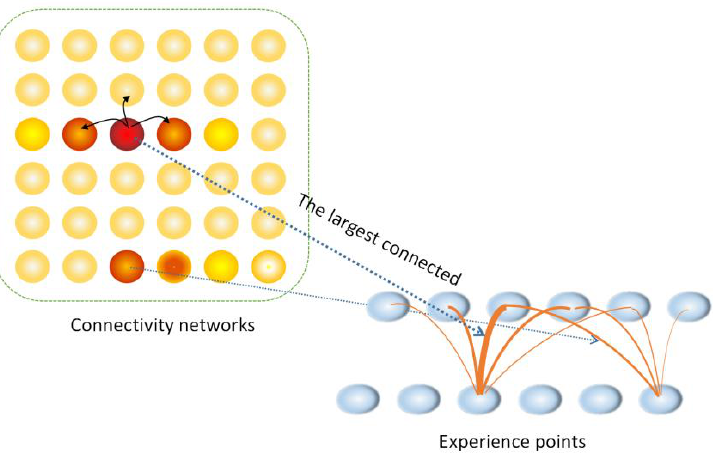
Figure 5. Schematic diagram of connectivity network.